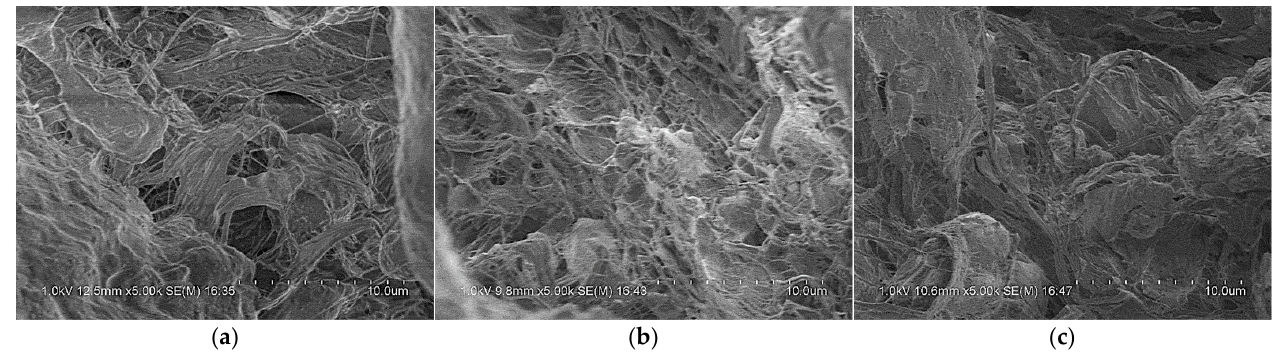
Figure 15. Scanning electron microscope photographs of recycled samples at different temperatures: ( a ) T = 100 °C; ( b ) T = 150 °C; ( c ) T = 200 °C.